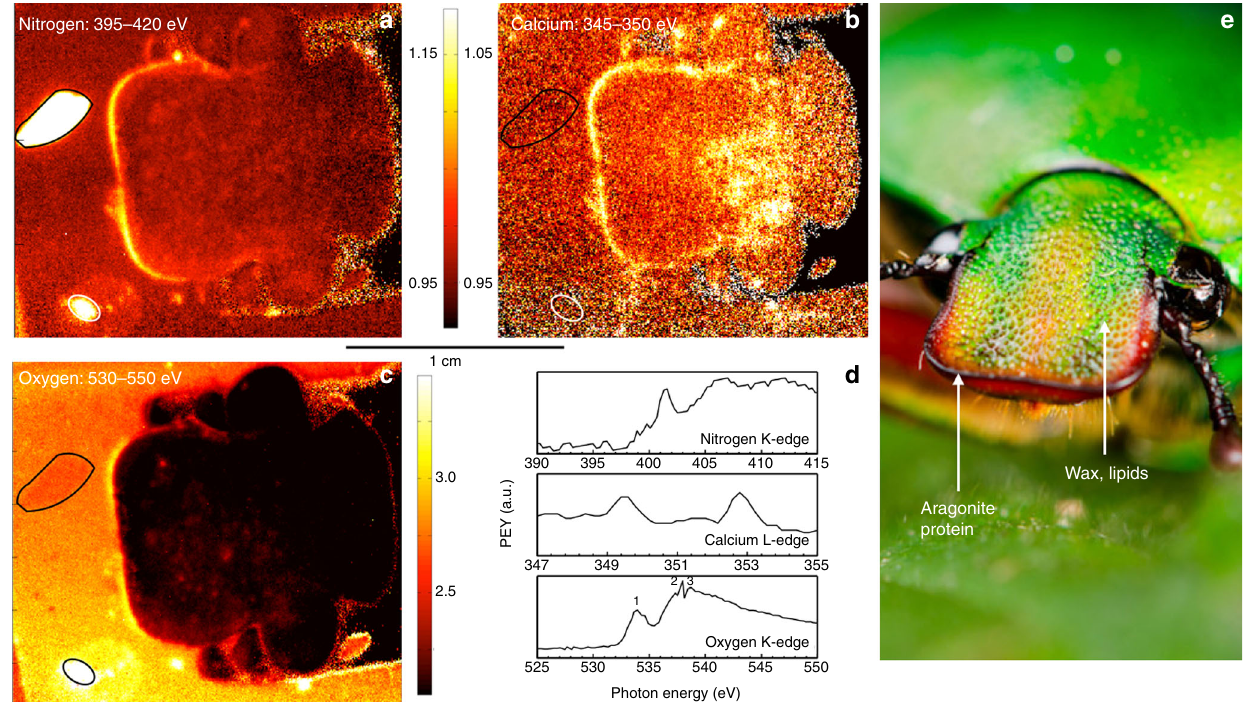
Fig. 5 Spectral analysis of the dorsal protrusion region. a NEXAFS image related to the nitrogen K-edge region at 395 – 420 eV. This spectral range corresponds to nitrogen bonds at the surface. b Image related to the calcium L-edge (345 – 350 eV). The presence of both nitrogen and calcium may be interpreted as biomineralized tissue near the scarab dorsal protrusion of the head. c Oxygen NEXAFS image in the 530 – 550 eV region. d Spectra extracted from the dorsal protrusion of the head. Areas marked in black or white indicate the position of albumin (top) and chitin (bottom) reference materials. All images and spectra are pre-edge normalized. e Photograph highlighting the surface chemistries found on the head of E. gralli